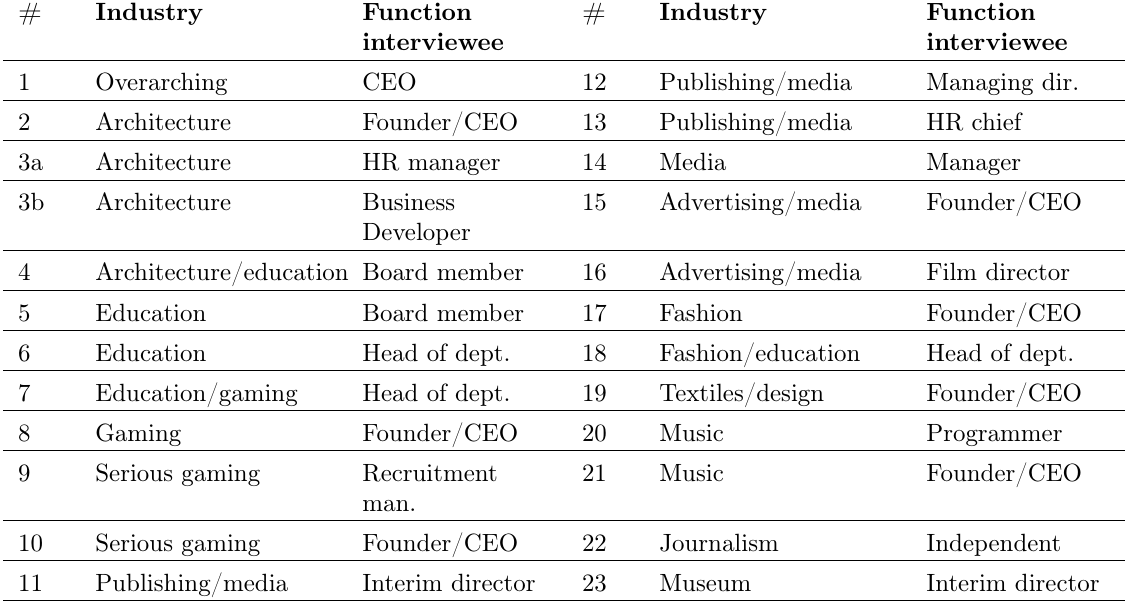
Table 1. Industries and Job Functions